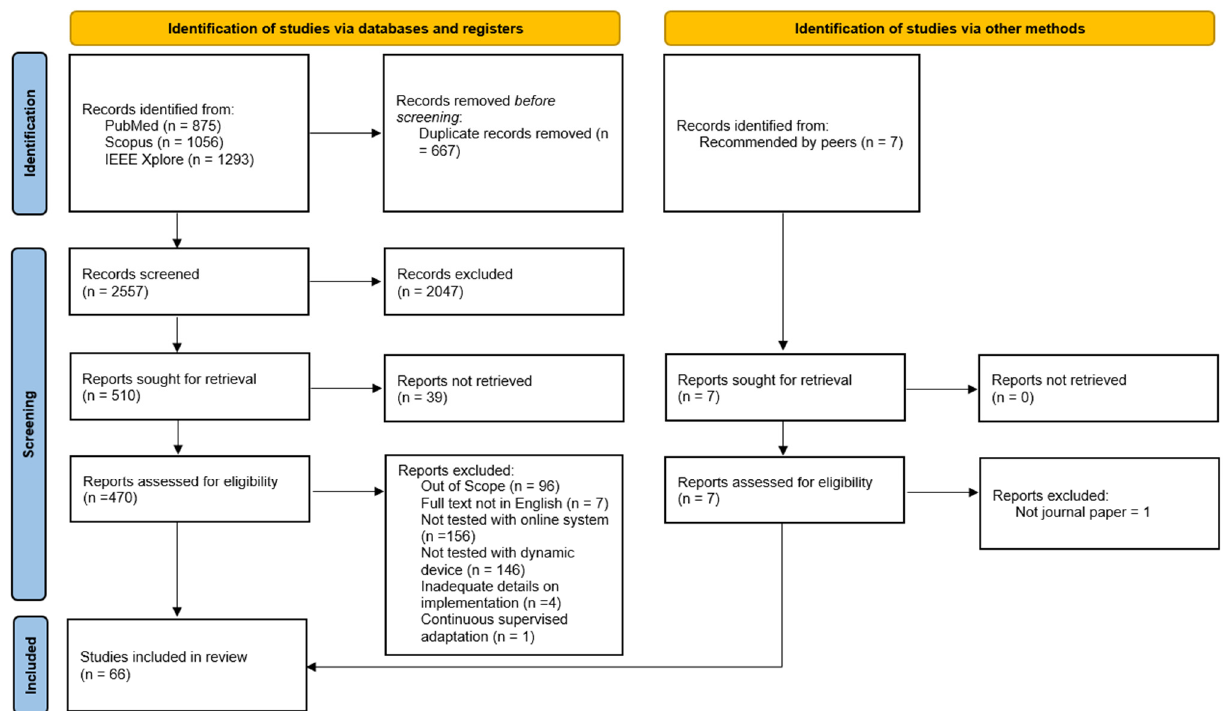
Figure 1. A summary of the paper selection process formatted using the template available at [6].